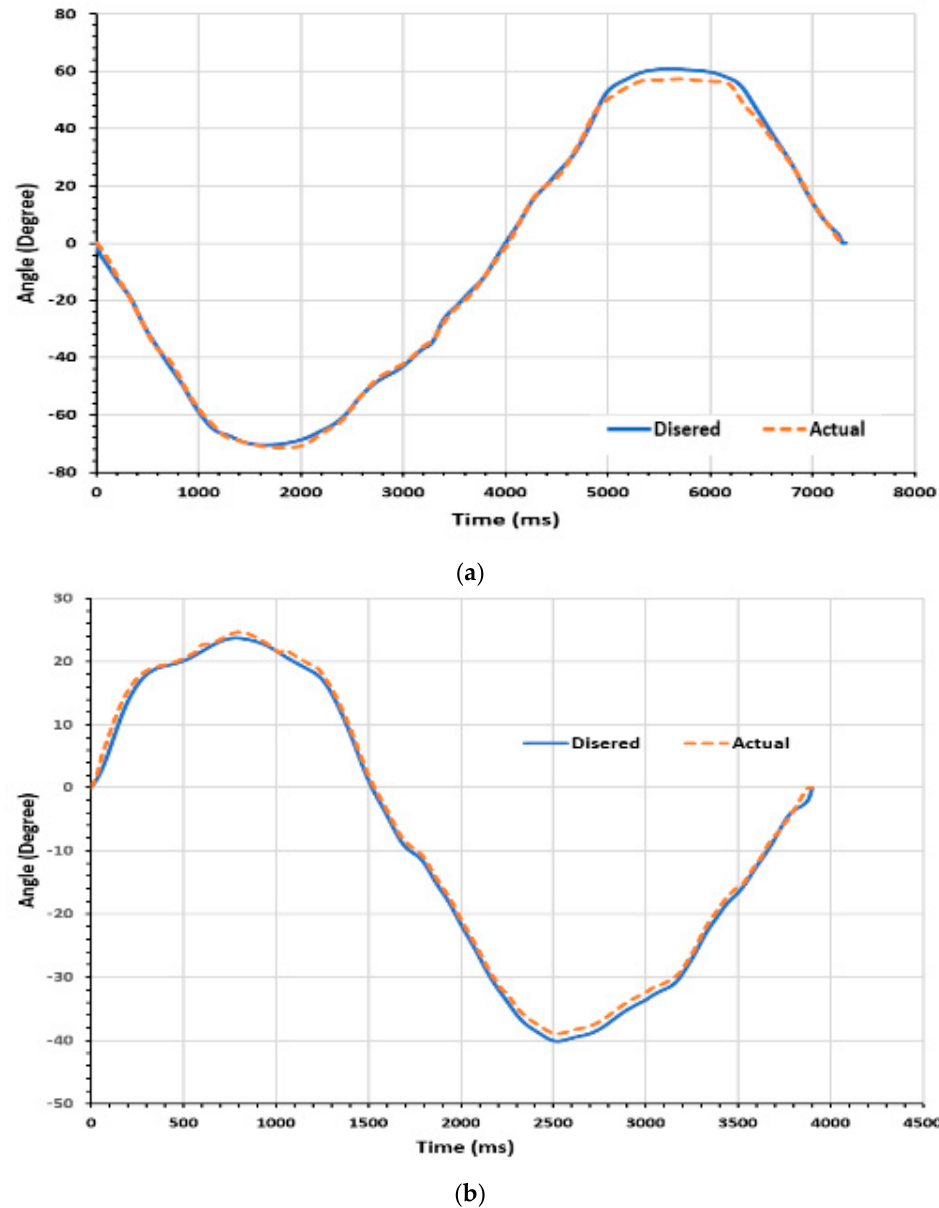
Figure 14. Continuous passive motion rehabilitation experiment of s typical; ( a ) wrist flexion/ extension joint; ( b ) wrist radial/ulnar deviation joint.